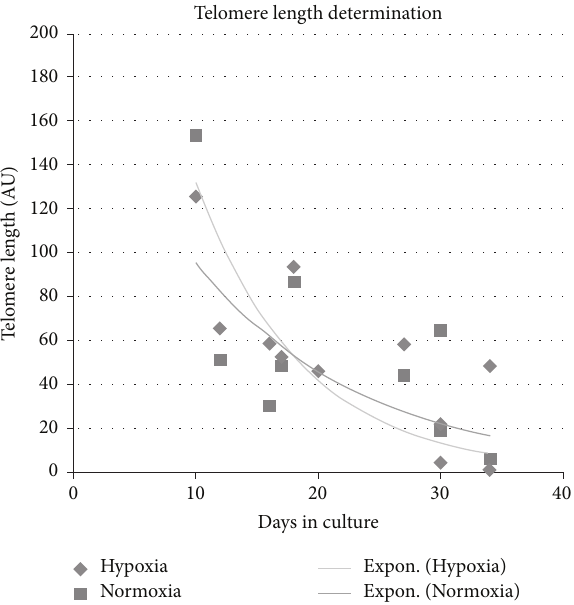
Figure 4: Effects of oxygen levels on telomeric length. Graph shows quantitative genomic PCR telomeric length determination performed with p53wt/wt mMSCs under hypoxic and normoxic conditions and with a pool of newborn mouse skin DNA as calibrator(setto100arbitraryunits,AU).Fittedlinesareexponential regression curves, and the differences are not